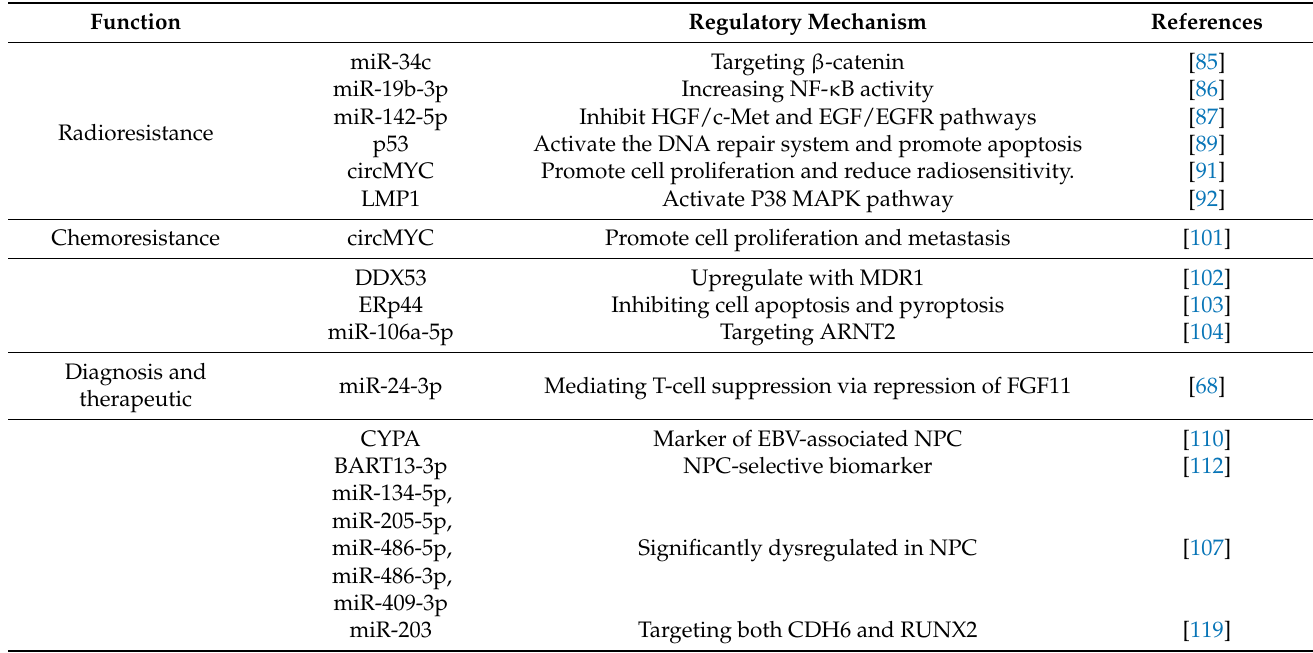
Table 1. Summary of the EVs content and their role in